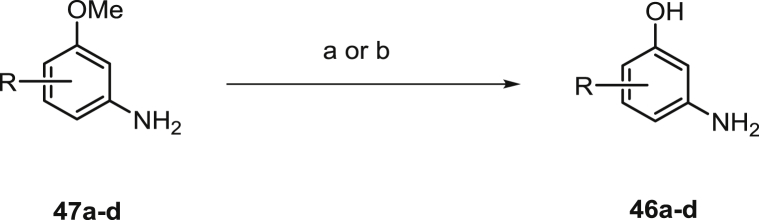
Synthesis of anilinophenols via demethylation. aReagents and conditions: (a) BBr3, DCM, -78 °C or (b) pyridinium chloride, 150 °C.